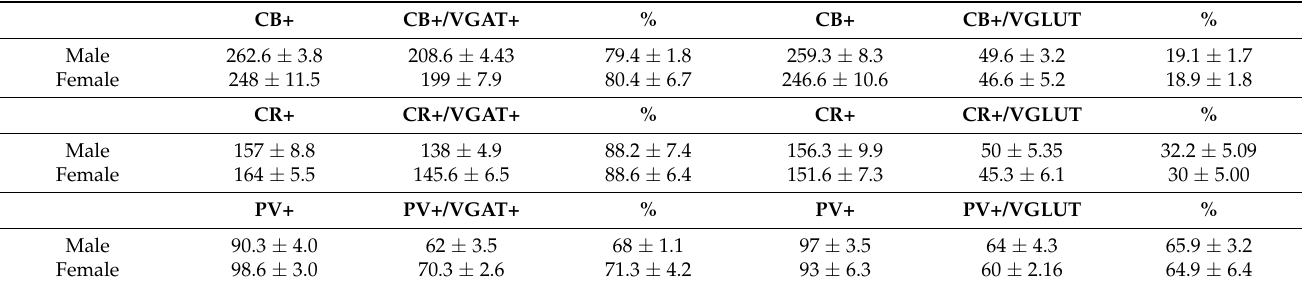
Table 1. The colocalization pattern of CB+, CR+ and PV+ neurons with VGAT and VGLUT in the preoptic area of the guinea pig. Data are presented as mean ± standard deviation